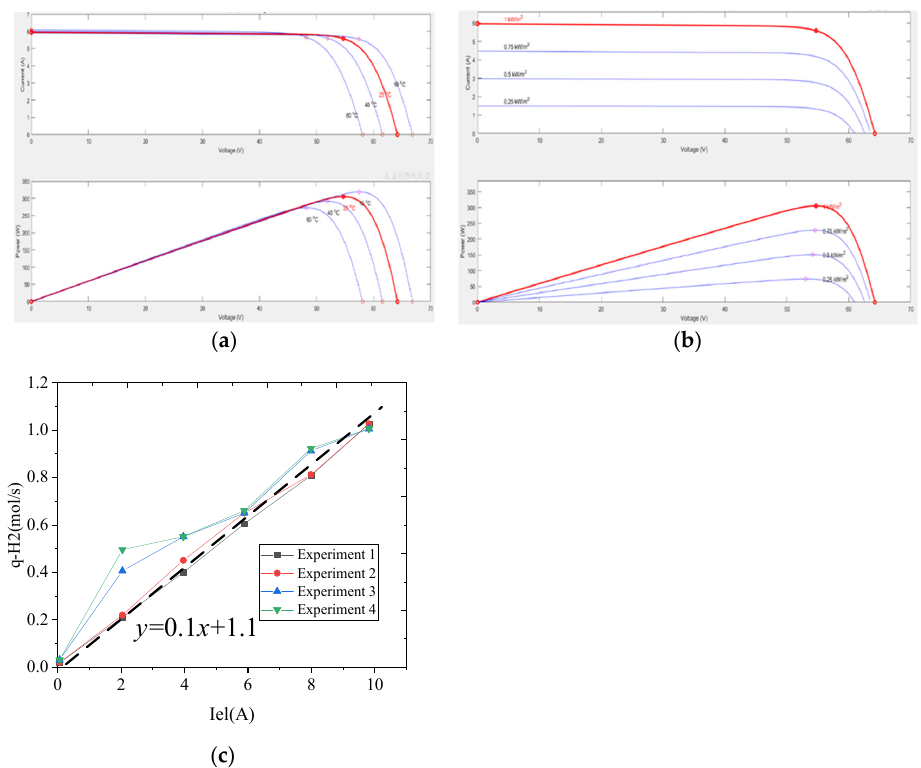
Figure 4. Relationship between the photovoltaic cell output characteristics and temperature: ( a ) output characteristic curve of the photovoltaic cell with ambient temperature under the same light intensity; ( b ) output characteristic curve of the photovoltaic cell with light intensity at the same ambient temperature; ( c ) relationship between the hydrogen generation rate and current in an electrolytic cell.